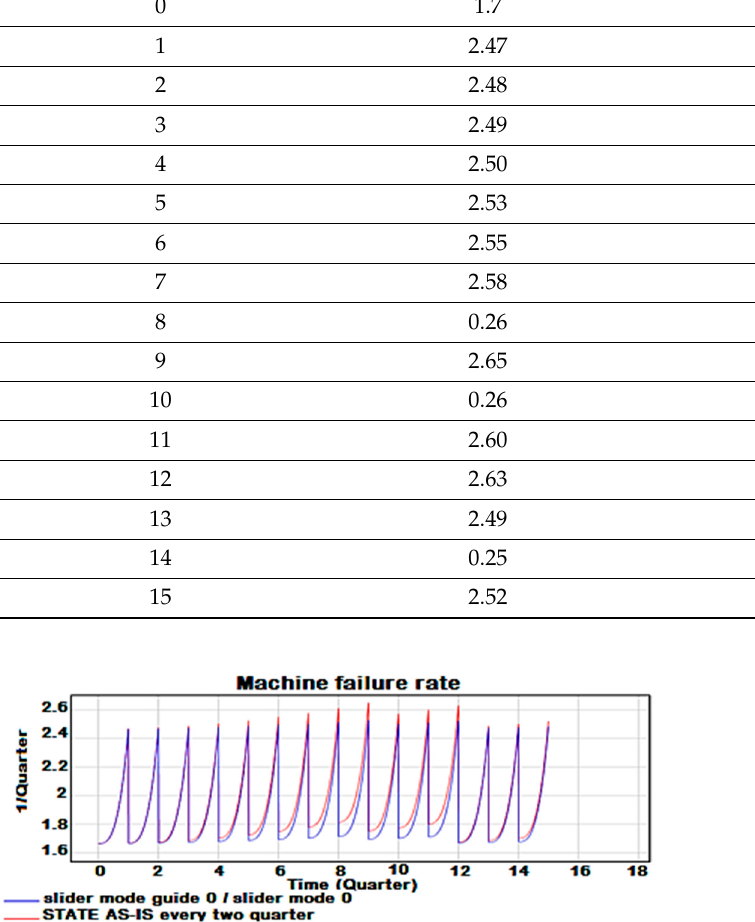
Table 4. AS-IS machine failure rate comparison.